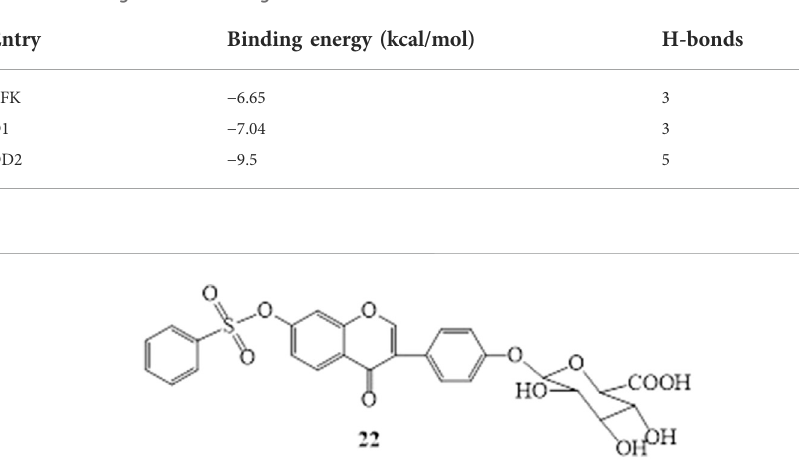
TABLE 1 Docking results of the ligands and